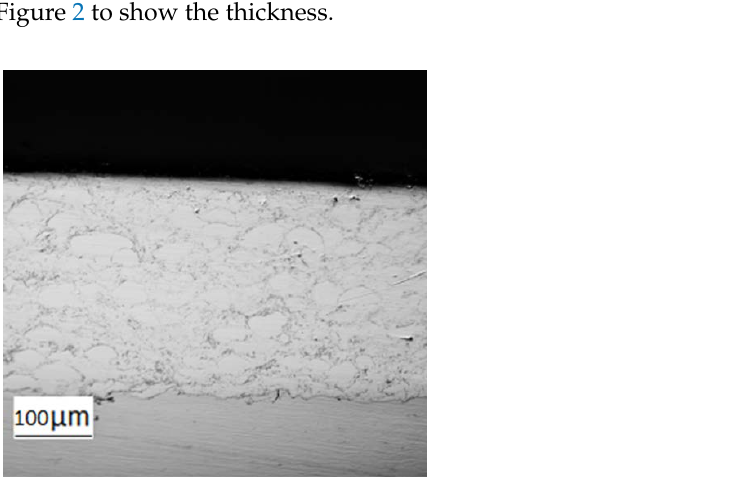
Figure 2. Micrograph of the coating to represent cross section thickness.